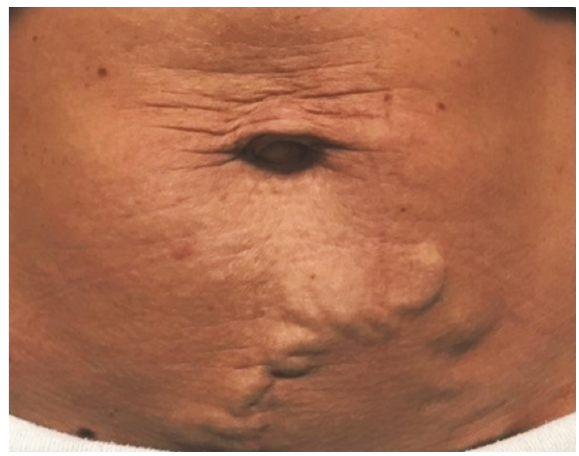
Figure 1: Patient presented with large tortuous varicosities at the lower abdomen and left